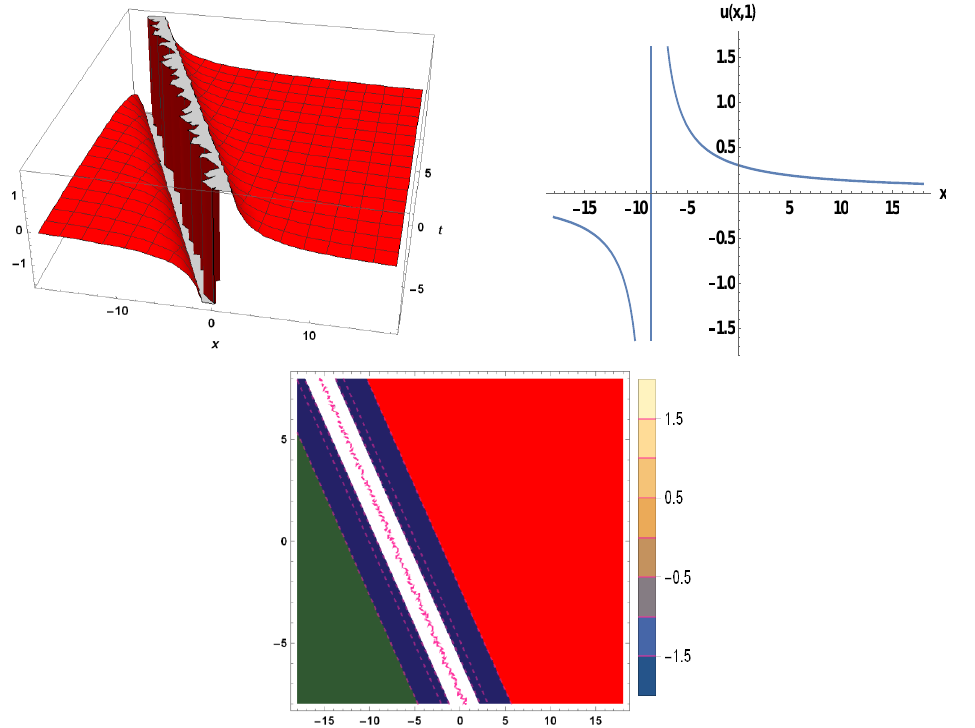
Figure 7. The solitary wave view of the 3D, 2D, and contour plots of U 7 ( x , t ).